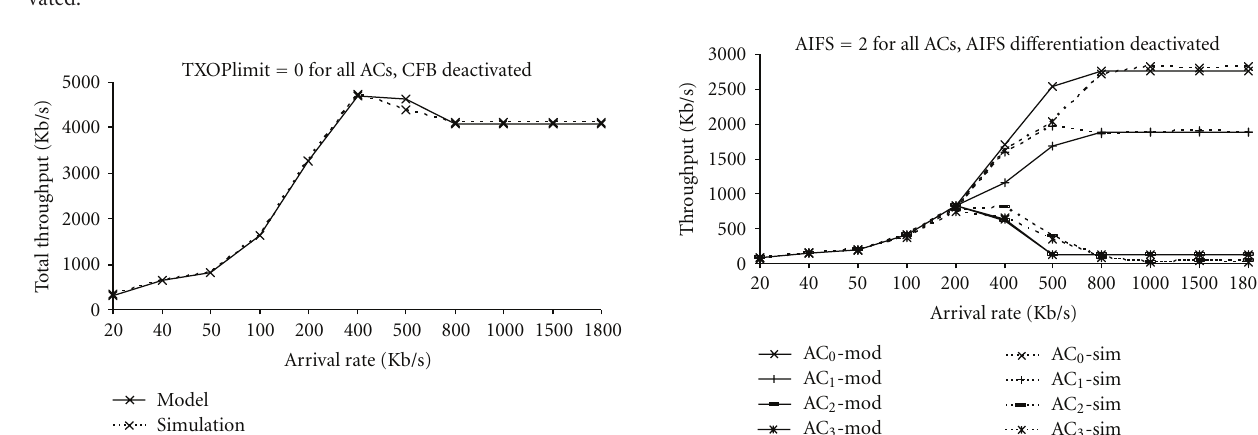
Figure 26: Access delay per AC—TXOPLimit deactivated.